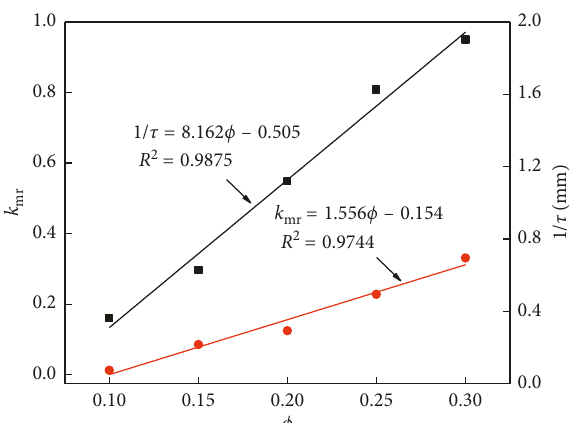
Figure 9: The variation of the minimum permeability ratio k average aperture 1/ τ with the variation of the porosity.